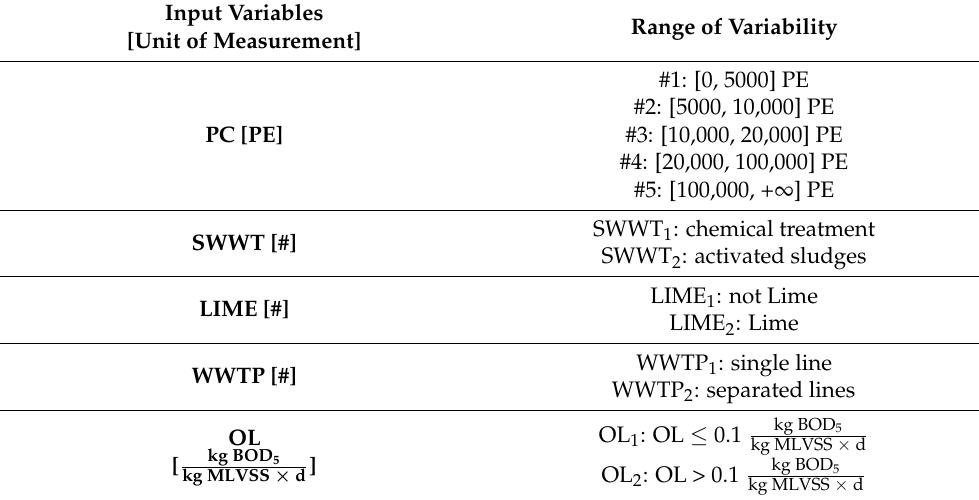
Table 3. List of the input parameters of the scenario